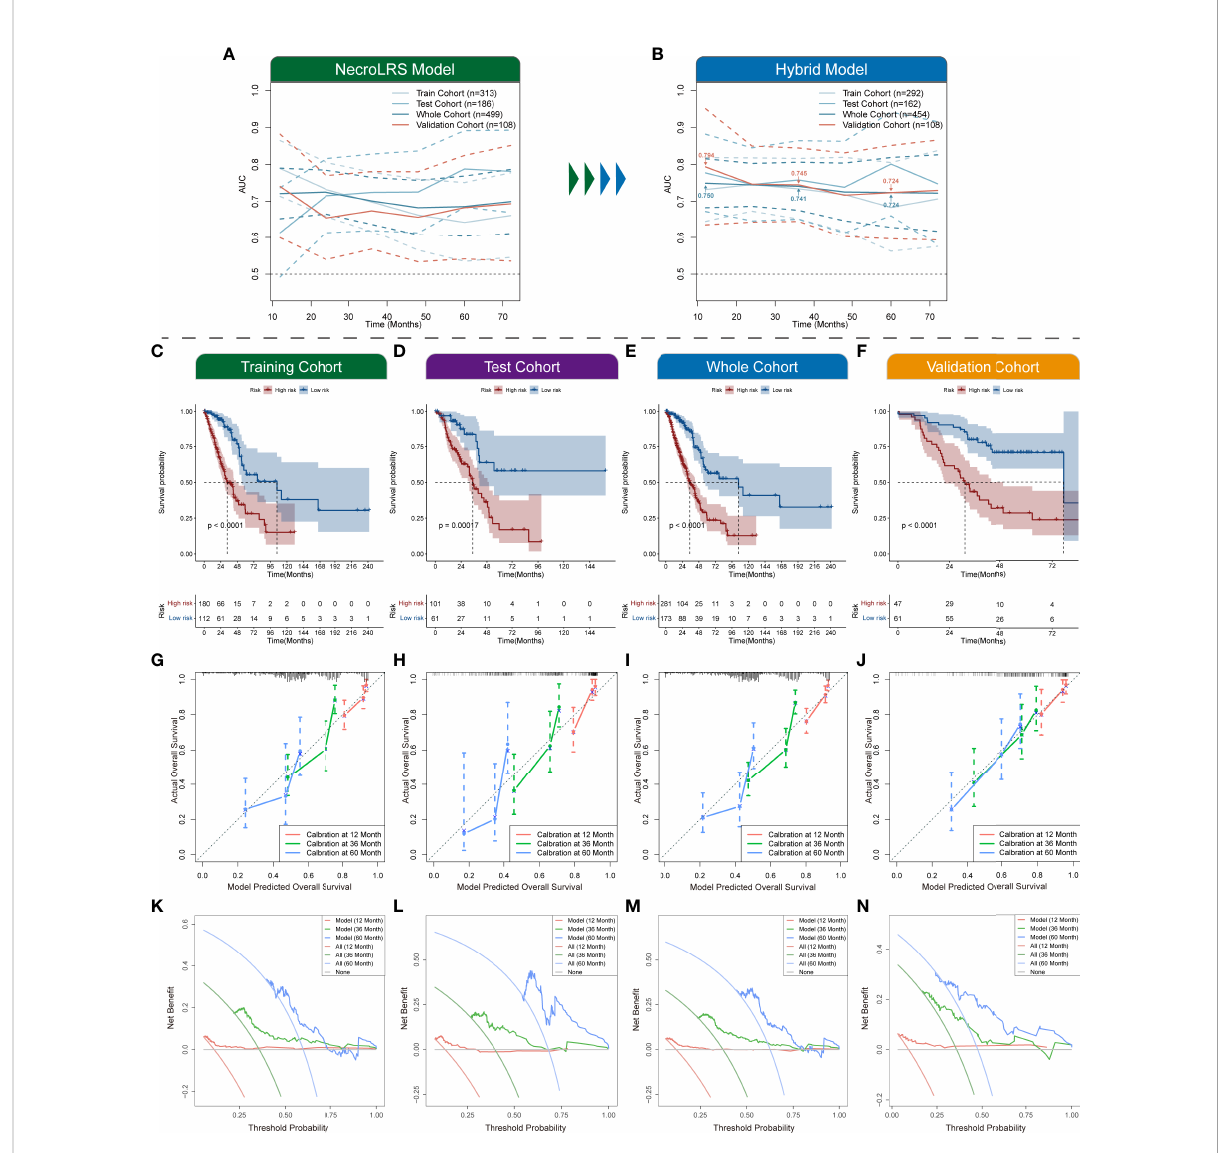
FIGURE 12 Exploration of necroptosis-related hybrid model. Time-dependent ROCs of both NecroLRS (A) and hybrid (B) model in training, test, whole, and validation cohorts. Additionally, the 1-, 3-, and 5-year AUC values of the hybrid model in the whole and validation cohorts were further annotated. (C – F) Kaplan-Meier survival analysis of high- and low-risk groups in training, test, whole, and validation cohorts, respectively. 1-, 3-, 5-year calibration curves (G – J) and DCA curves (K – N) of training, test, whole, and validation cohorts are shown ( “ None ” : assume no patient will die at the speci fi c time point and offer treatment to no one; “ All ” : assume all patients will die at the speci fi c time point and therefore treat everyone; “ Model ” : gives the expected net bene fi t of hybrid model on each patient under different threshold